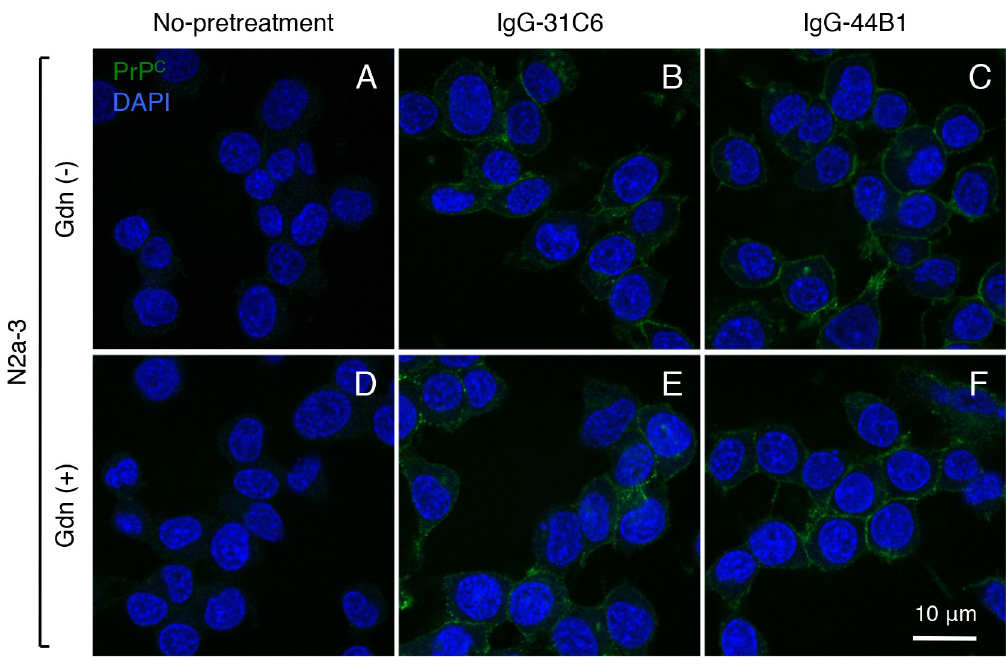
Fig 7. Detection of PrP C on the surface of N2a-3 cells. N2a-3 cells were incubated with DMEM containing 10 nM IgG-31C6 (B, E) and IgG-44B1 (C, F) for 2 days. The cells were stained with 1 μ g/ml Alexa Fluor 647-labeled mAb 132 after treatment with (D–F) or without (A–C) 5 M GdnSCN (green). The leftmost images show negative controls for antibody-treatment (A, D). Cell nuclei were stained with DAPI